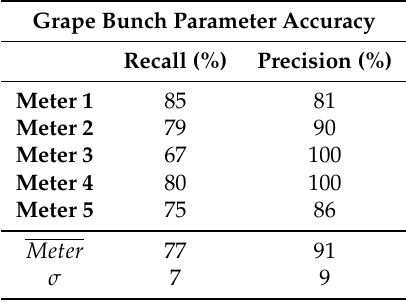
Table 5. Grape bunch recall and precision for yield parameter estimation of the SMPH grapevine row. Grape Bunch Parameter Accuracy Recall